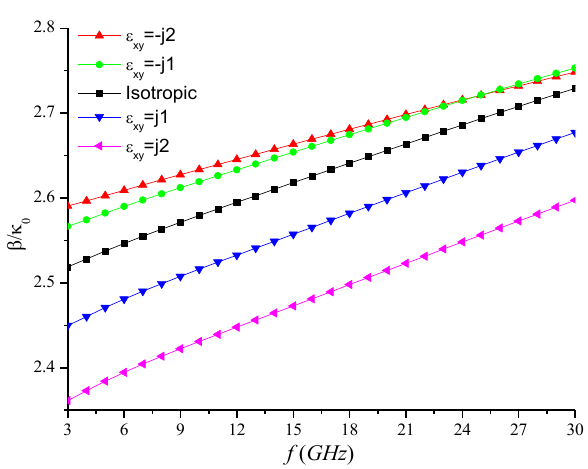
Figure 6.a: Effect of imaginary valued e xy on the normalized phase constant